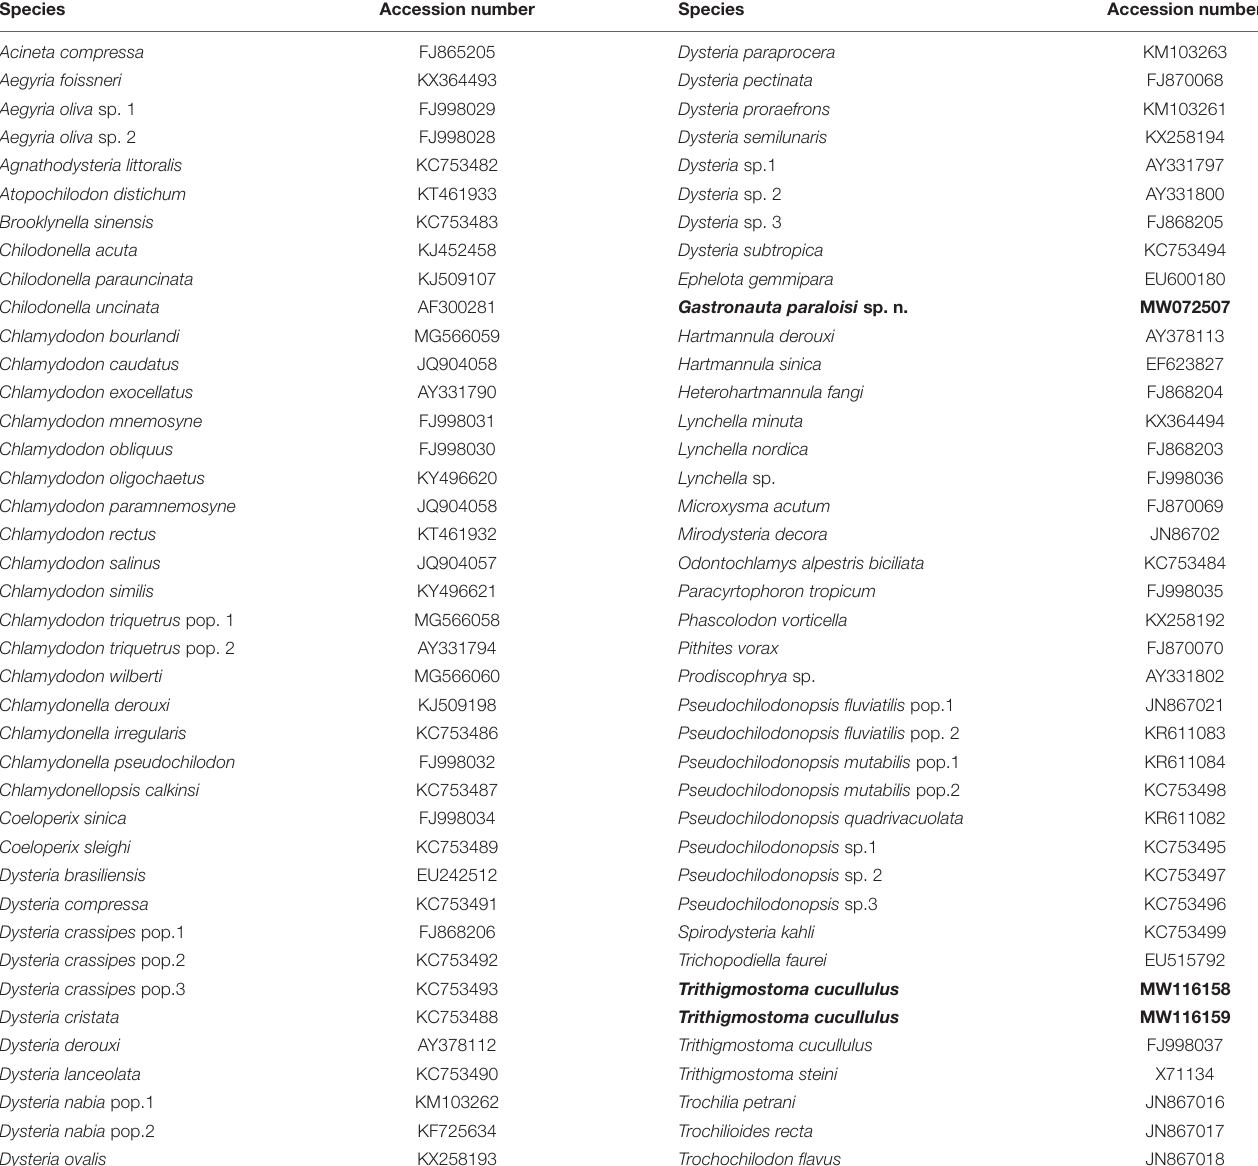
TABLE 1 | GenBank accessions of SSU rDNA sequences used in the phylogenetic